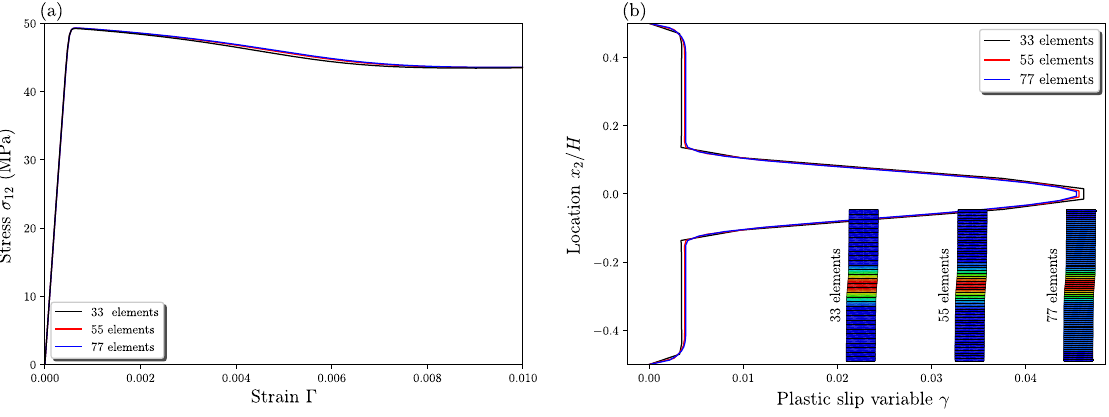
Figure 7. Results of the vertical slip case: ( a ) stress–strain curves and ( b ) distributions of plastic scalar variable γ along x 2 − direction at Γ = 0.01 for different mesh refinements ( l en / H = 0.1, l dis = 0, H π = − 500 MPa, n = 2 )